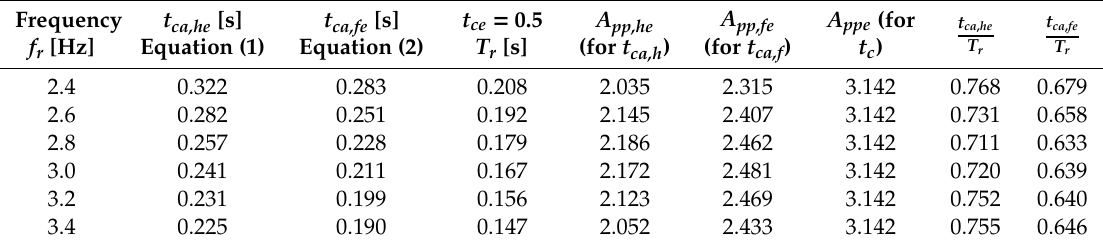
Table 4. Estimated parameters of the F VGRF